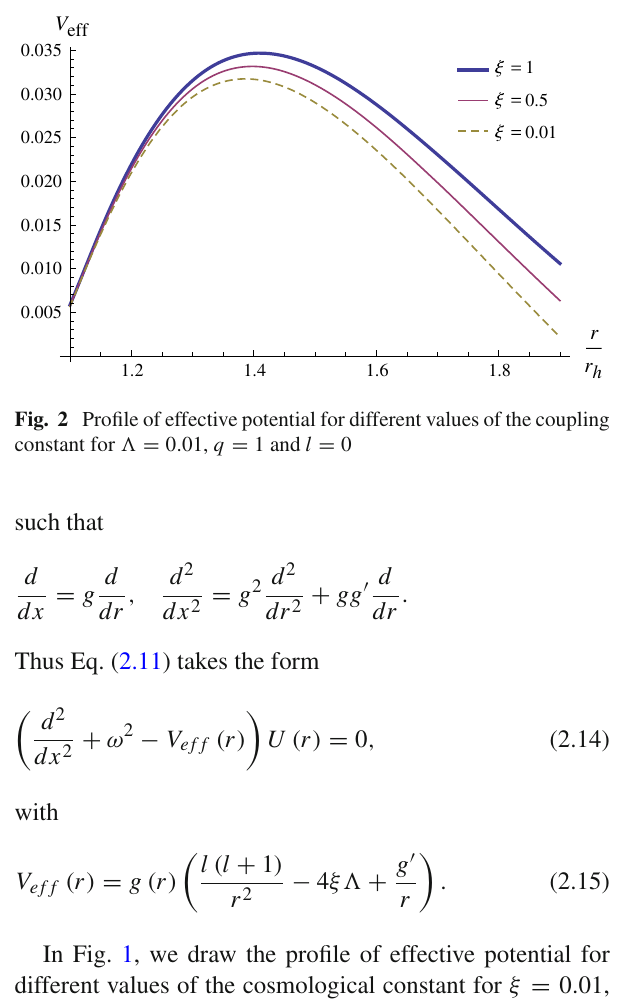
Fig. 1 Profile of effective potential for different values of the cosmo- logical constant for ξ = 0 . 01, q = 1 and l = 0